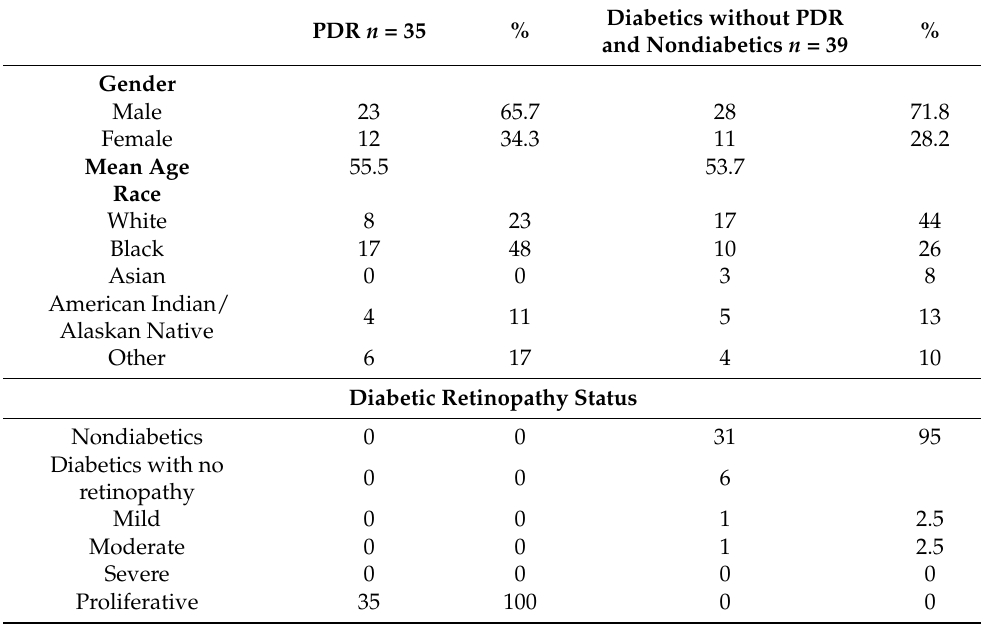
Table 2. Basic Demographics among Study